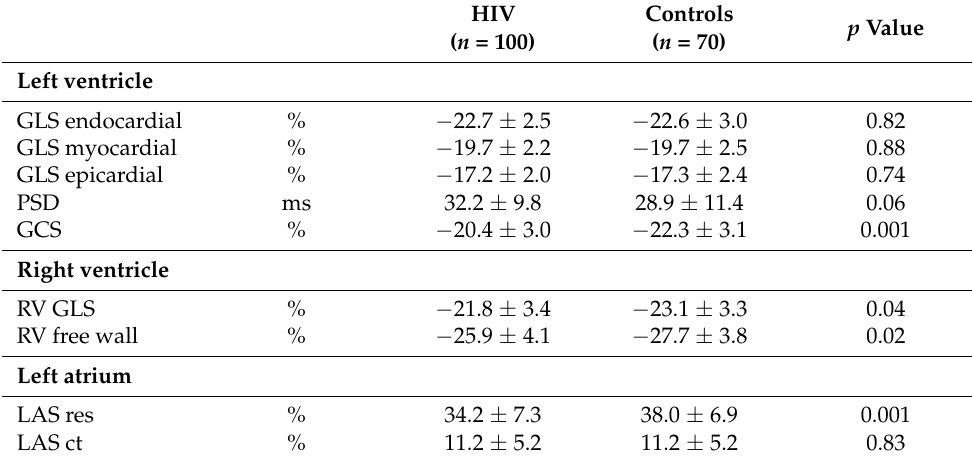
Table 3. Speckle tracking-derived strain